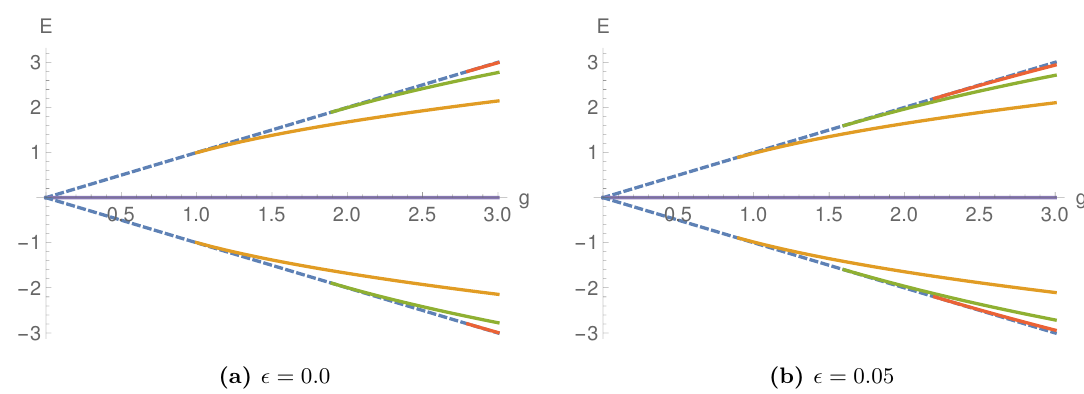
Figure 3. Energy of fermion bound states as a function of coupling parameter g . The scalar field background is the kink of the toy